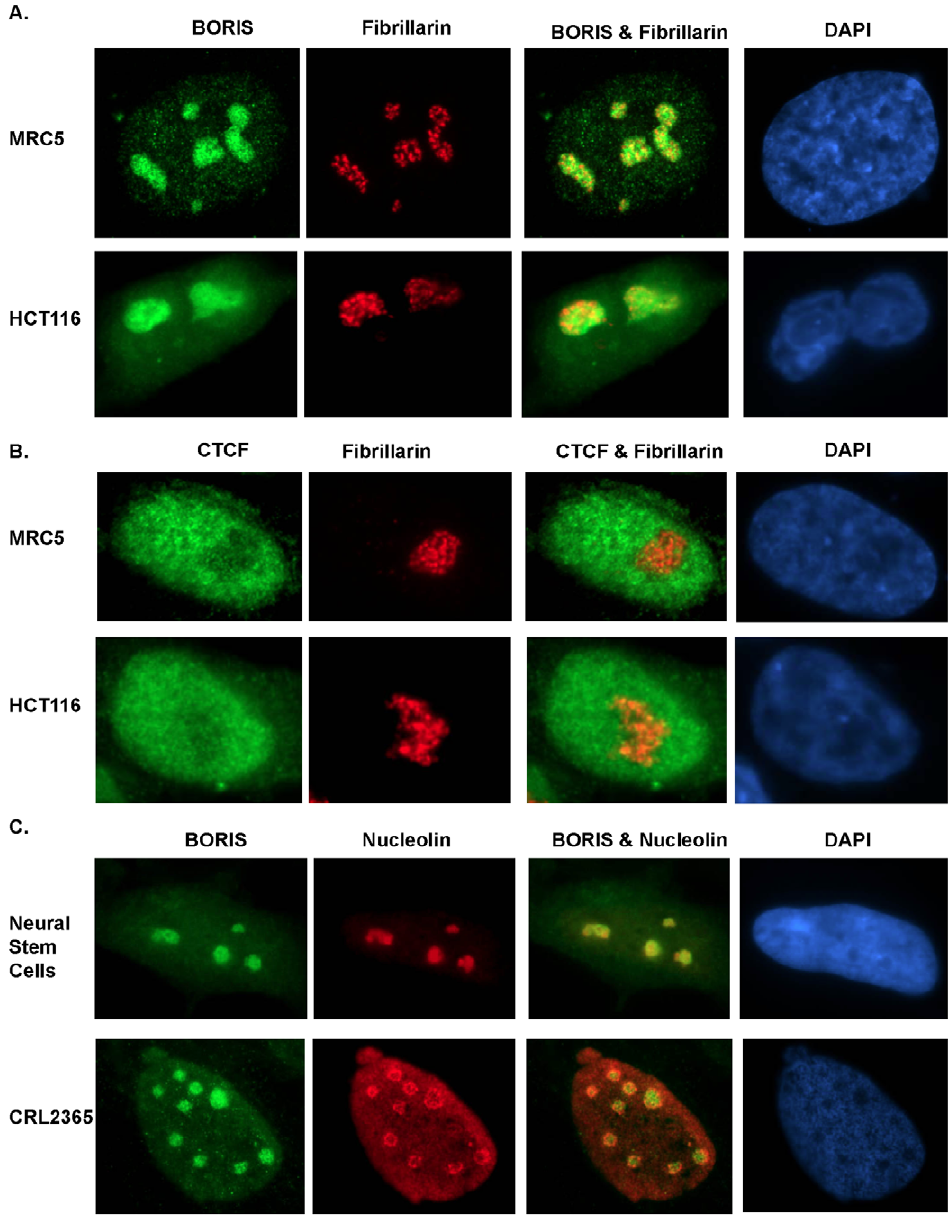
Figure 4. Cellular distribution of BORIS in human cell lines and tissues. A, B Immunofluorescence imaging of BORIS or CTCF staining in green (Alexa 488) together with fibrillarin staining in red (Alexa 594) in MRC5 and colorectal cell line HCT116 showing enrichment of BORIS, but not CTCF, within the nucleolus. Cells were counterstained with 4 9 , 6-Diamidino-2-phenylindole (DAPI) shown in blue. BORIS and fibrillarin are close neighbours with each other and the dense fibrillar component (DFC) of the nucleolus. Images are shown at 100x magnification. C Double immunostaining showing BORIS staining in green (Alexa 488) within the Nucleolin region (red, Alexa 594) in human neural stem cells and glioblastoma cell line CRL2365. Cells were counterstained with 4 9 , 6-Diamidino-2-phenylindole (DAPI) shown in blue. Images are shown at